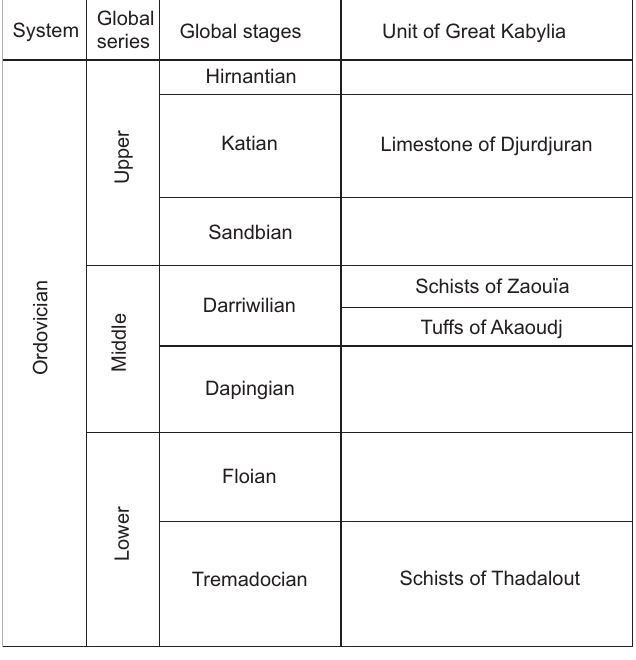
Fig. 1. Lithostratigraphic units defined in Great Kabylia (after Termier and Termier 1950a; Baudelot and Géry